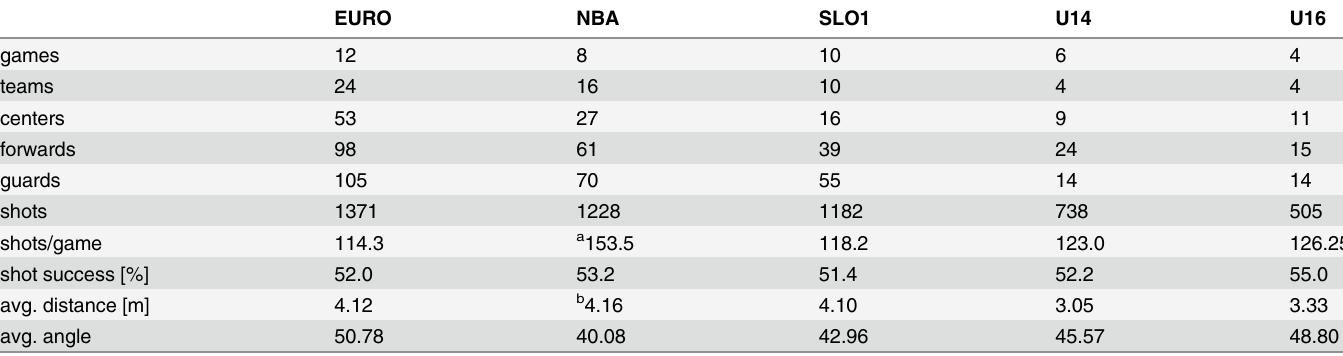
Table 1. Summary of acquired